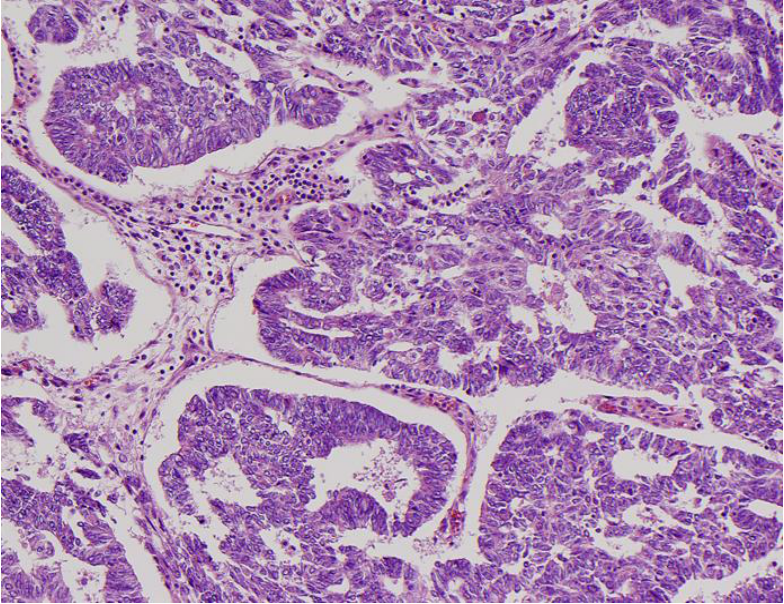
FIGURE 5. Section of ureter with endometrioid adenocarcinoma forming glandular